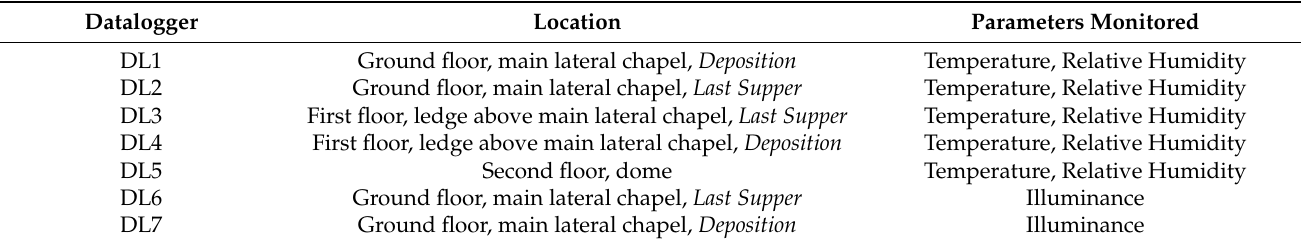
Table 7. The locations and monitored parameters of the dataloggers.